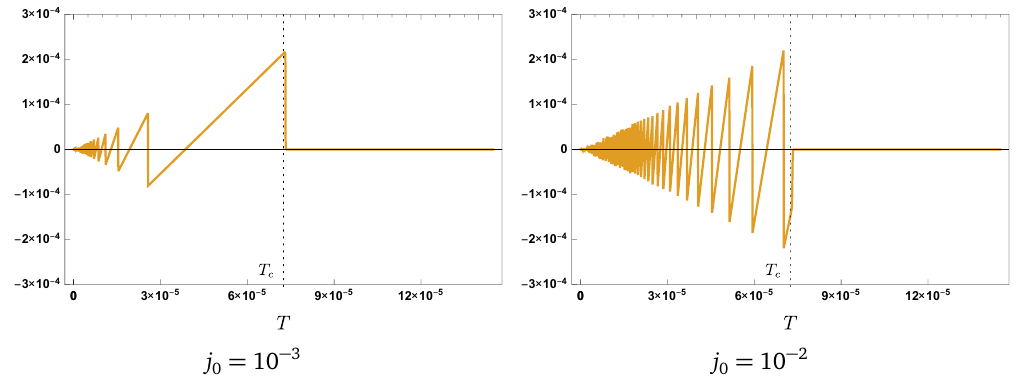
Figure 4: Imaginary part of the free energy as a function of the temperature. We see that j is related to the number of oscillations. A similar behavior will be ob- 0 served in SYK for the dual parameter r . The parameters used for these plots are = 10 3 , N ( j ) = k = 1, S 0